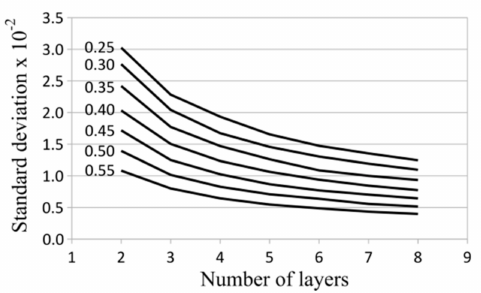
Figure 10. Standard deviations for different numbers of layers and a different saturation density of matrix with